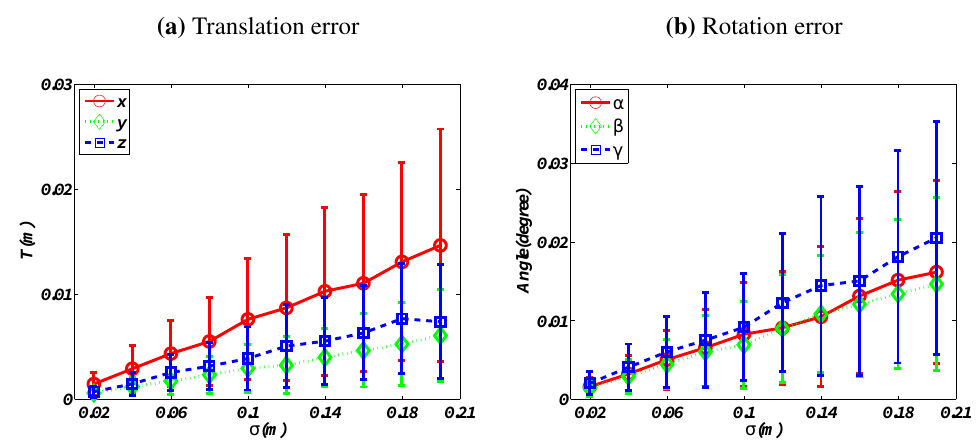
Figure 3. Errors vs . the noise level on LIDAR points. ( a ) presents the translation’s absolute errors in X , Y , and Z directions. ( b ) shows the displaced Euler angle [ (cid:11); (cid:12); (cid:13) ] T .